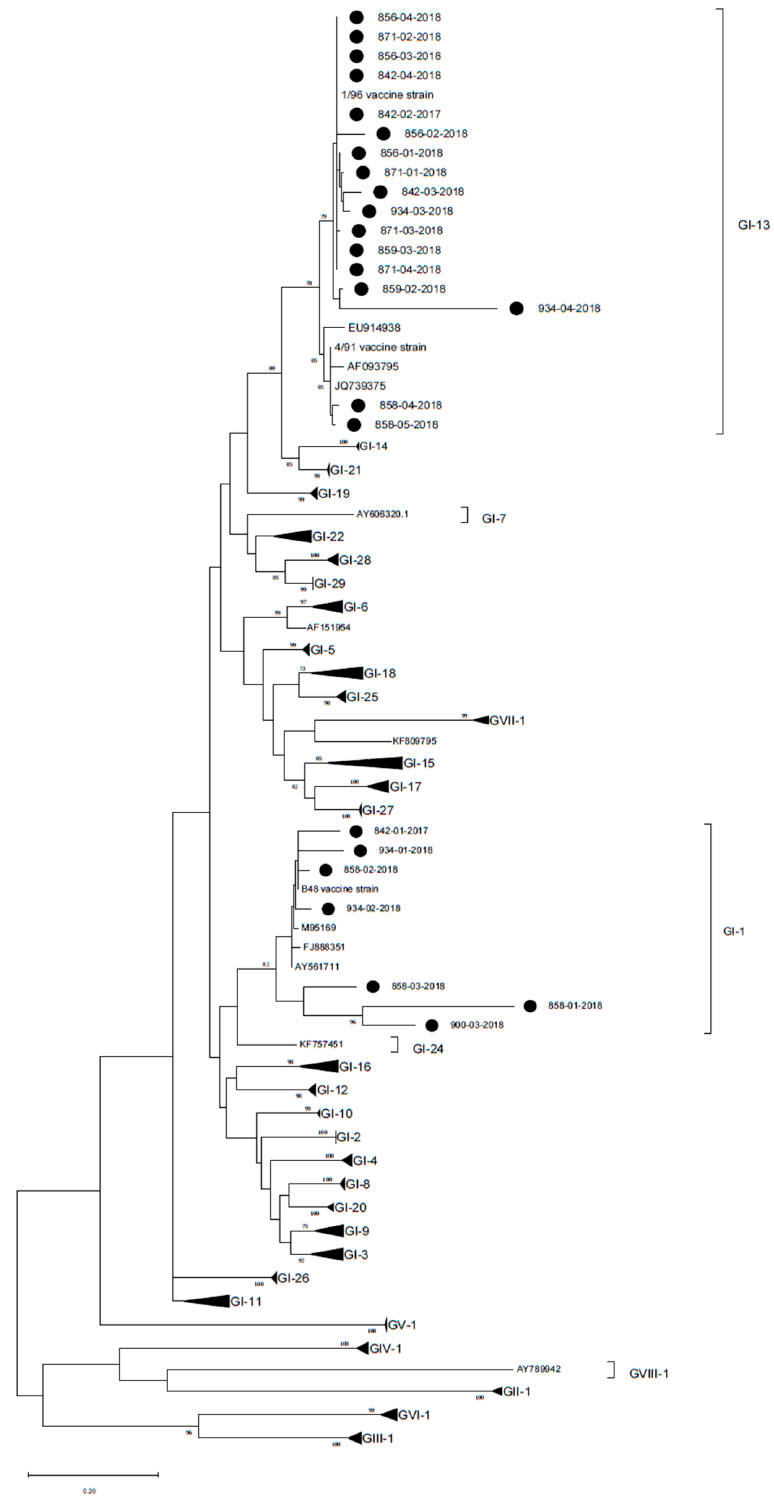
Figure 4. Phylogenetic tree reconstructed using IBV strain references from Valastro et al. (2016) [34]. French strains identified in the present study are marked with a black circle. The tree was recon- structed using the maximum likelihood method and general time reversible model with gamma distribution. Bootstrap support (>70%) is shown next to the branches. The tree is drawn to scale, with branch lengths measured in the number of substitutions per site. This analysis involved 123 nucleotide sequences and a total of 295 positions in the final dataset.